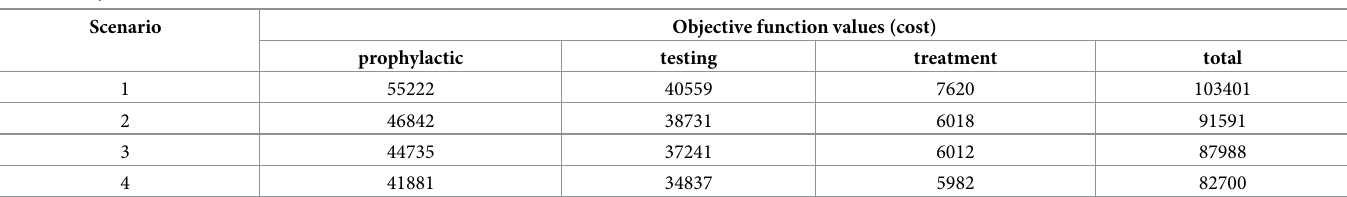
Table 2. Objective function values of different scenarios. unit: RMB.